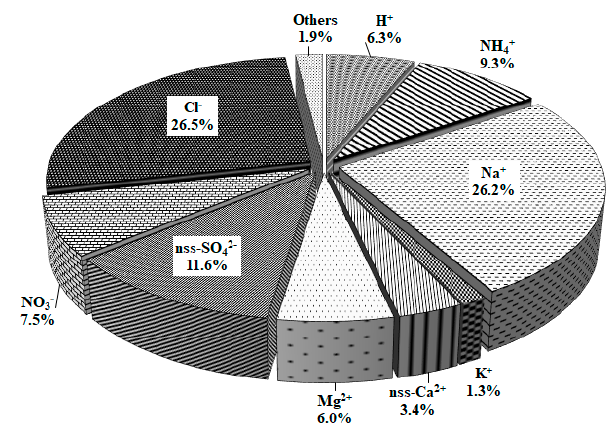
Figure 4. Composition ratio of ionic species in precipitation during the study period.